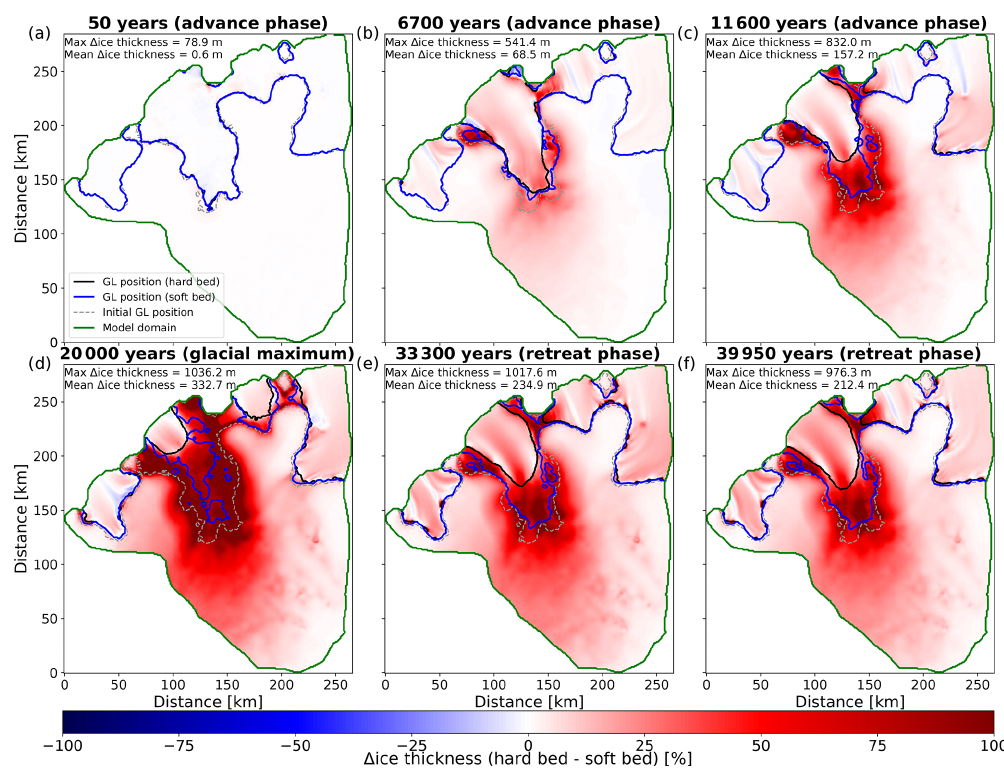
Figure 9. Differences in plane view of ice thickness and grounding-line positions between the hard- and soft-bed simulations at selected time slices. (a) – (d) show differences in the advance phase, and (e, f) show differences in the retreat phase.